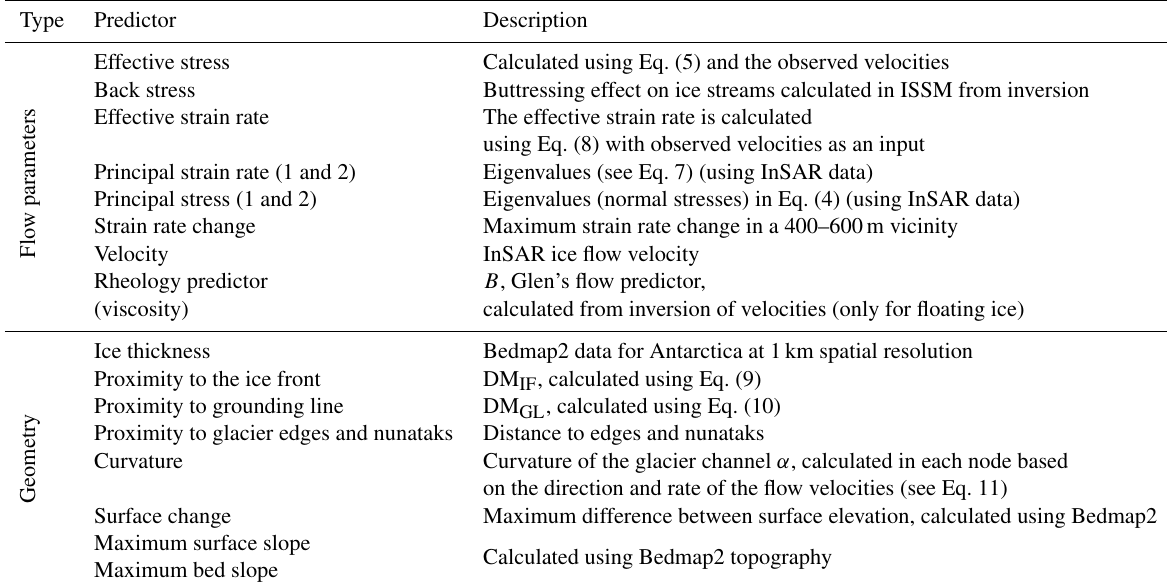
Table 2. Predictor factors